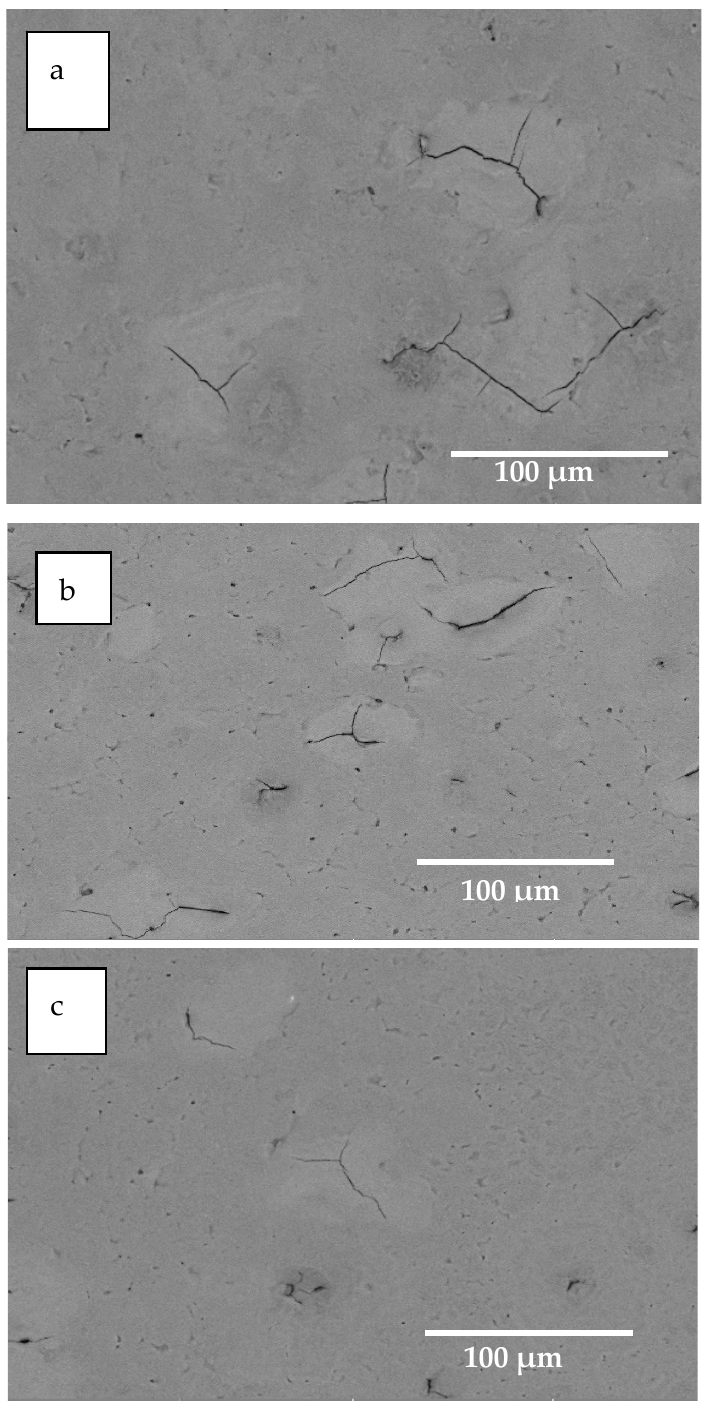
Figure 3. SEM morphology micrographs of the Al–20Si–5Mg alloy surface irradiated using HCPEB. ( a ) 5 pulse specimen, BSE image; ( b ) 15 pulse specimen, BSE image; ( c ) 25 pulse specimen, BSE image.